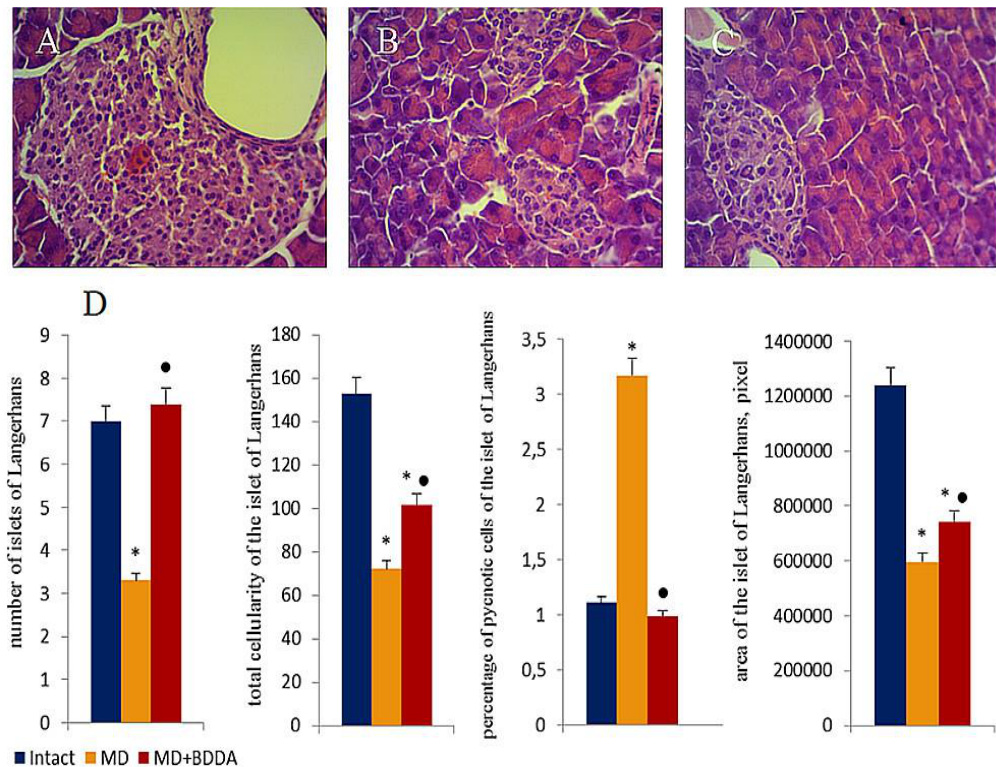
Figure 5. Photomicrographs of representative pancreas sections obtained from male C57BL/6 mice at d70. Tissues were stained with haematoxylin-eosin. ( A) Sections from control group; ( B) Sections from mice with metabolic disorders (MD); ( C) Sections from mice with MD treated with BDDA from d49-d70. Langerhans islets were examined morphologically by measuring the islet area, total islet cells and the amount of pyknotic cells. At least 10 photomicrographs of the pancreas tissue at × 400 magnification were taken for each experimental animal from all experimental groups. ( D) Number of Langerhans islets, total cellularity of the Langerhans islets, percentage of pyknotic cells in Langerhans islets and the area Langerhans islets. Groups: intact—a control group from intact mice, MD—mice with metabolic disorders (MD), MD+BDDA—mice with MD treated by BDDA. Results are presented as the mean ± SEM. *: significance of difference compared with control ( p < 0.05); ●: significance of difference compared with the MD group ( p < 0.05).